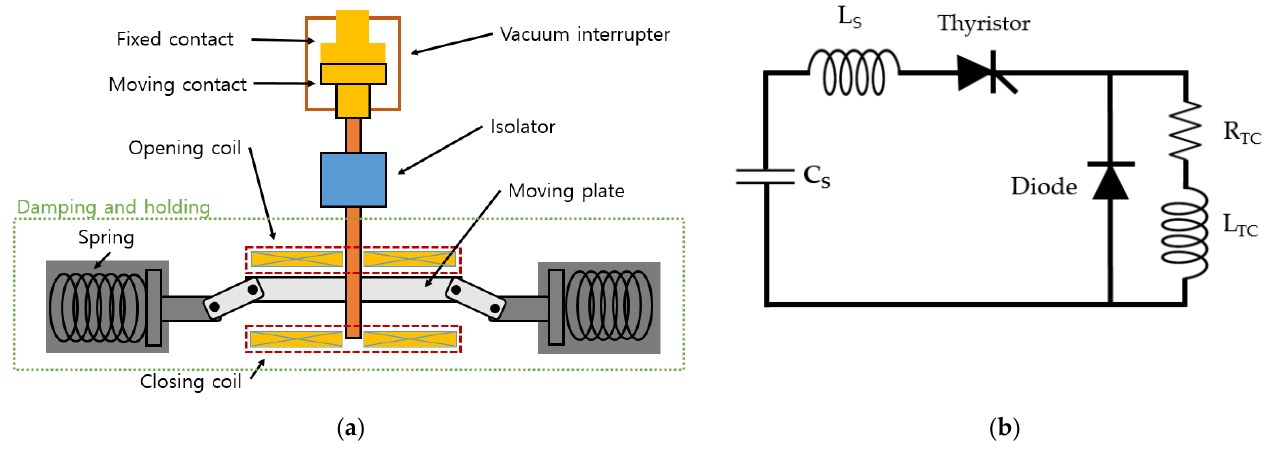
Figure 4. Thomson coil actuator: ( a ) diagram; ( b ) equivalent Thomson coil operation circuit.